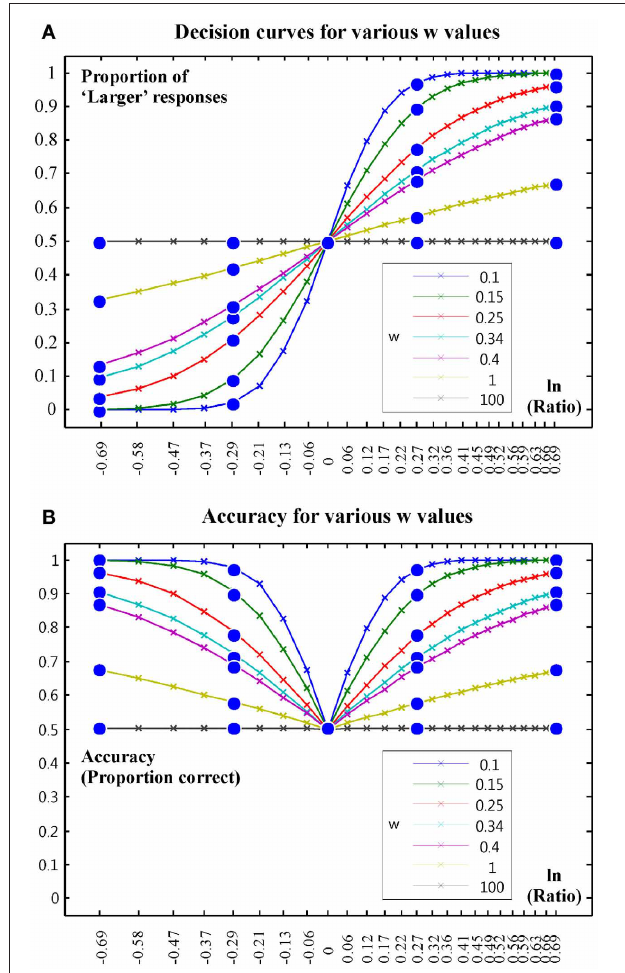
FIGURE 1 | Illustration of decision curves and accuracy outcomes for various w -values. (A) Decision curves for various w values. (B) Accuracy for various w